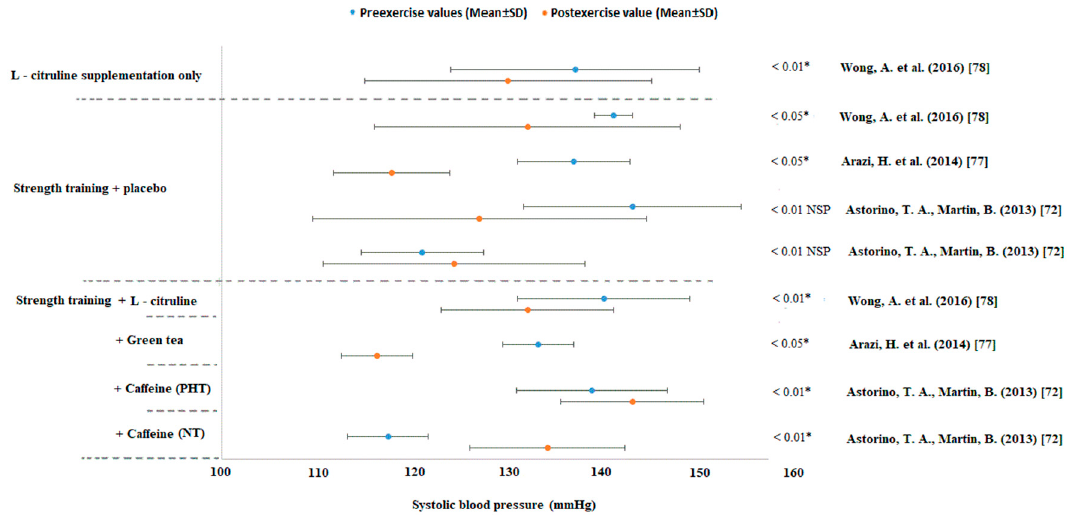
Figure 3. Changes in systolic blood pressure (mmHg) in supplement studies. Abbreviations: SD = standard deviation, * significant difference on reported “ p ” value. NSP = not significant according to the post hoc test.